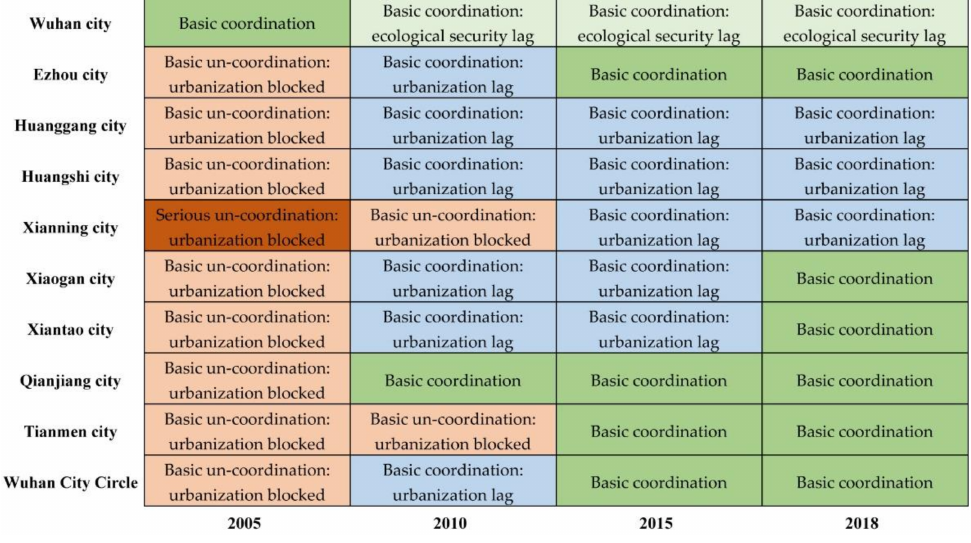
Figure 7. The classification of coupling coordination